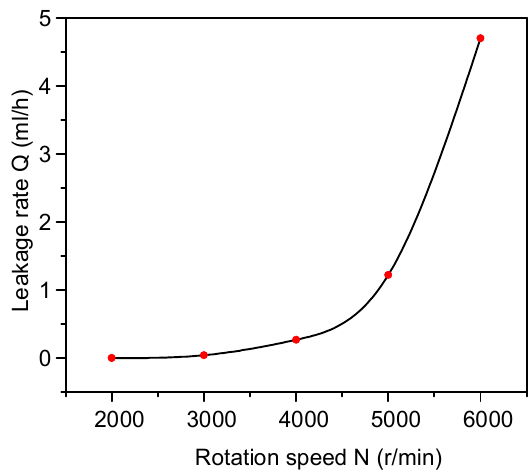
Figure 10. Variation in the leakage rate with rotation speed.